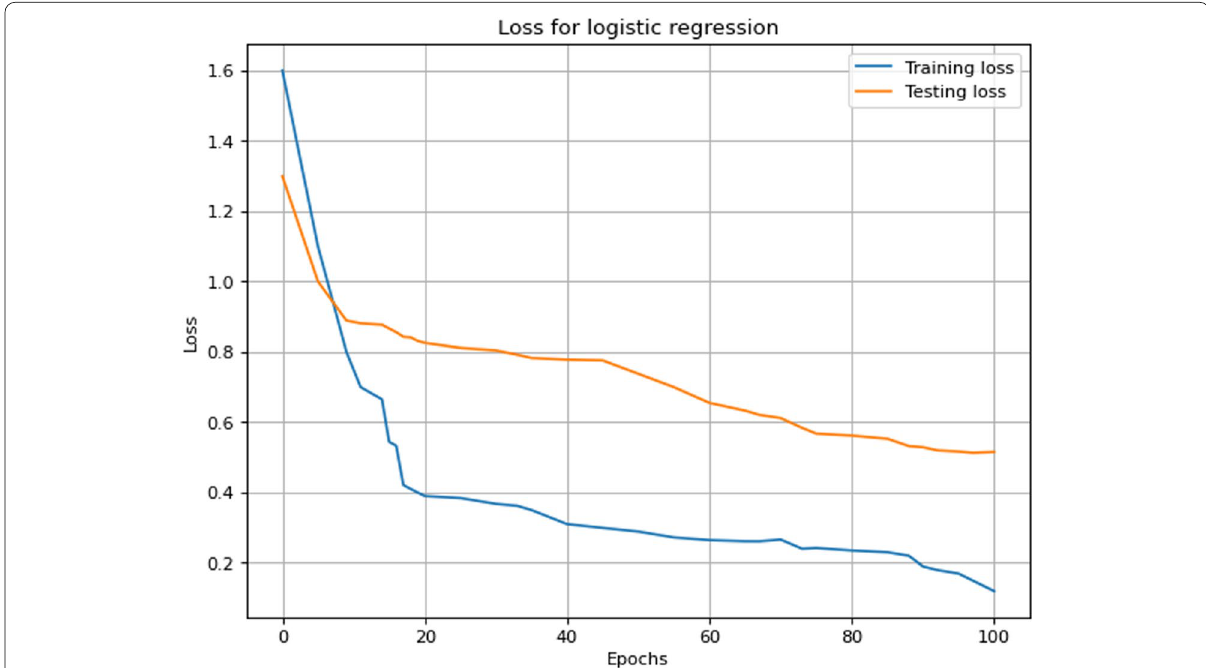
Fig. 17 Loss for our proposed model with logistic